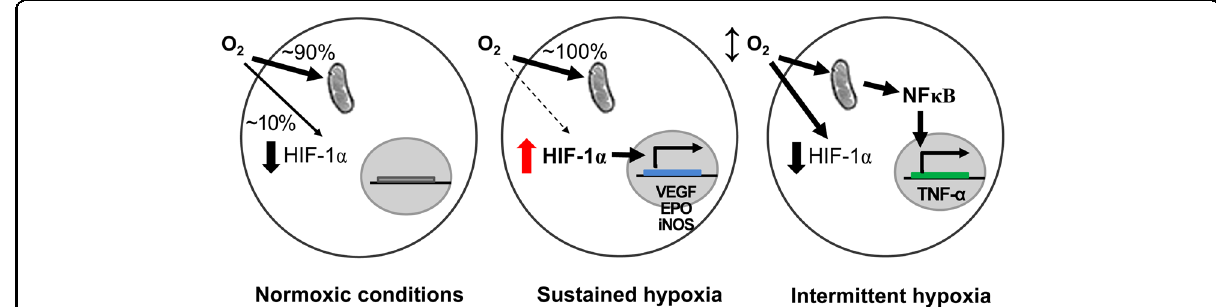
Fig. 2 Hypoxia and HIF-1 α stabilization. Under normoxic conditions, mitochondrial respiration consumes more than 90% of oxygen in humans. The remaining cytosolic oxygen (approximately 10%) is suf fi cient for HIF-1 α degradation. During sustained hypoxia, the mitochondria use up almost all the oxygen and the free cytosolic oxygen is exhausted, causing HIF-1 α stabilization. Activated HIF-1 α induces the transcription of many genes, such as VEGF, EPO, and iNOS. However, the response to intermittent hypoxia differs from the response to sustained hypoxia. Intermittent hypoxia may not remove a suf fi cient amount of cytosolic free oxygen to allow HIF-1 α stabilization; instead, intermittent hypoxia activates NF κ B probably through mitochondrial stress, resulting in the production of TNF- α , an in fl ammatory mediator